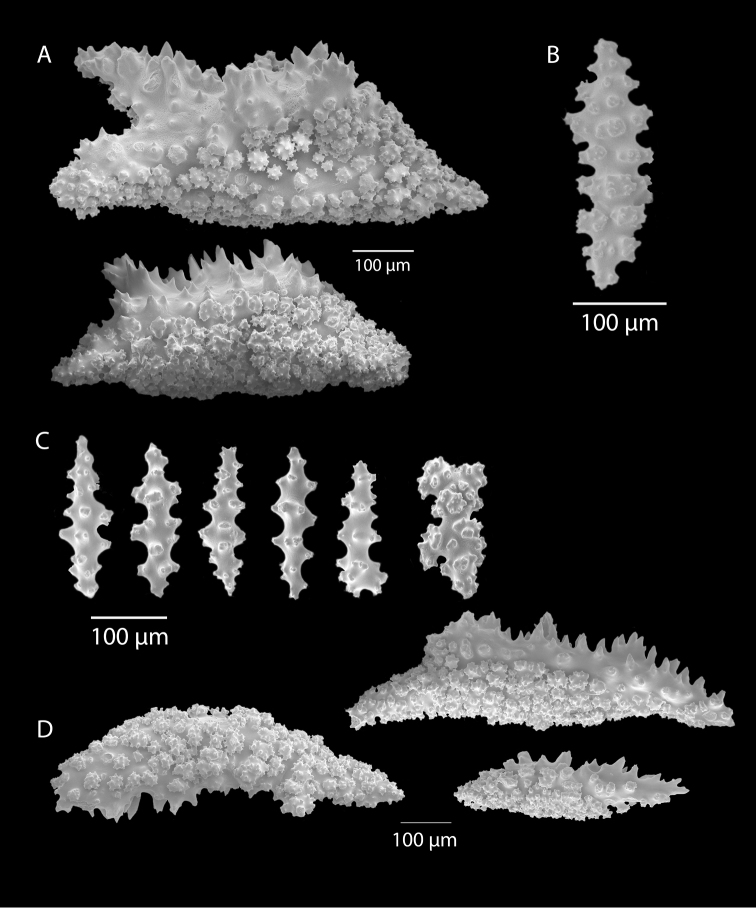
Muriceafruticosa, SBMNH 265940, SEM image. A, D Calycular and coenenchymal unilateral spinous spindles B, C Axial sheath A Large nudibranch-type sclerites B Typical spindle C Smaller spindles D tardigrade-type spindles.